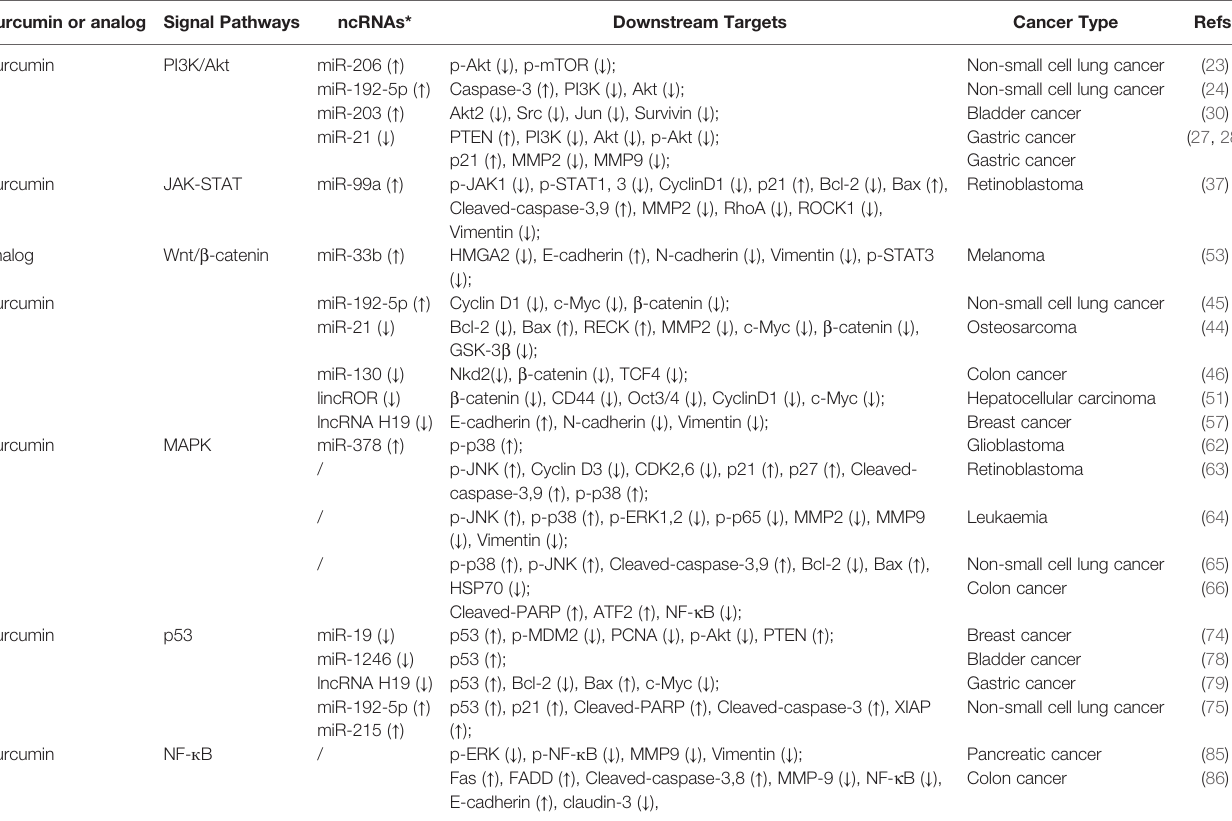
TABLE 1 | Curcumin modulates cellular signaling pathway and ncRNAs in cancers. Curcumin or analog Signal